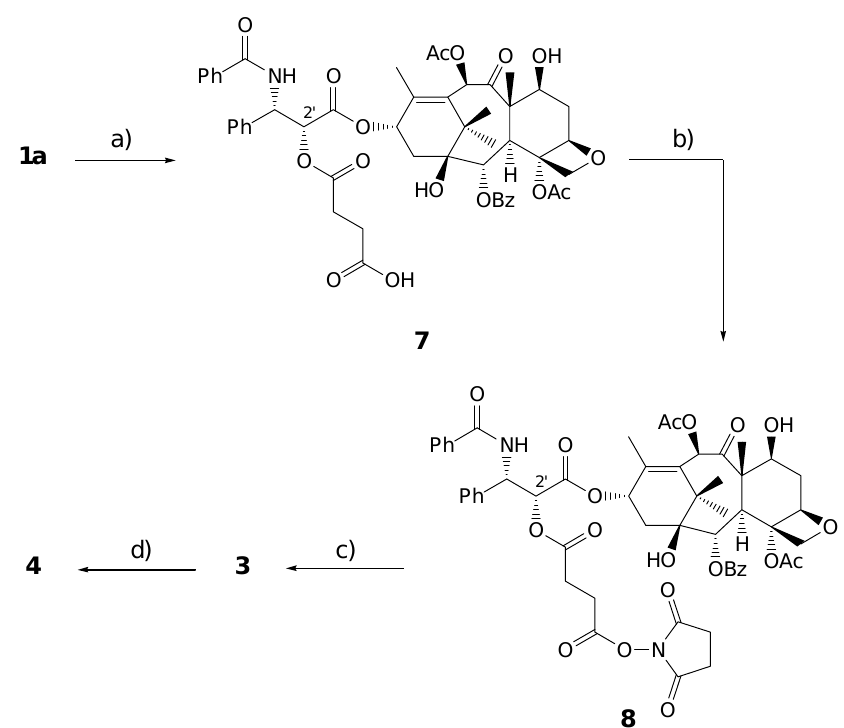
Scheme 1. Preparation of Bioconjugate 3